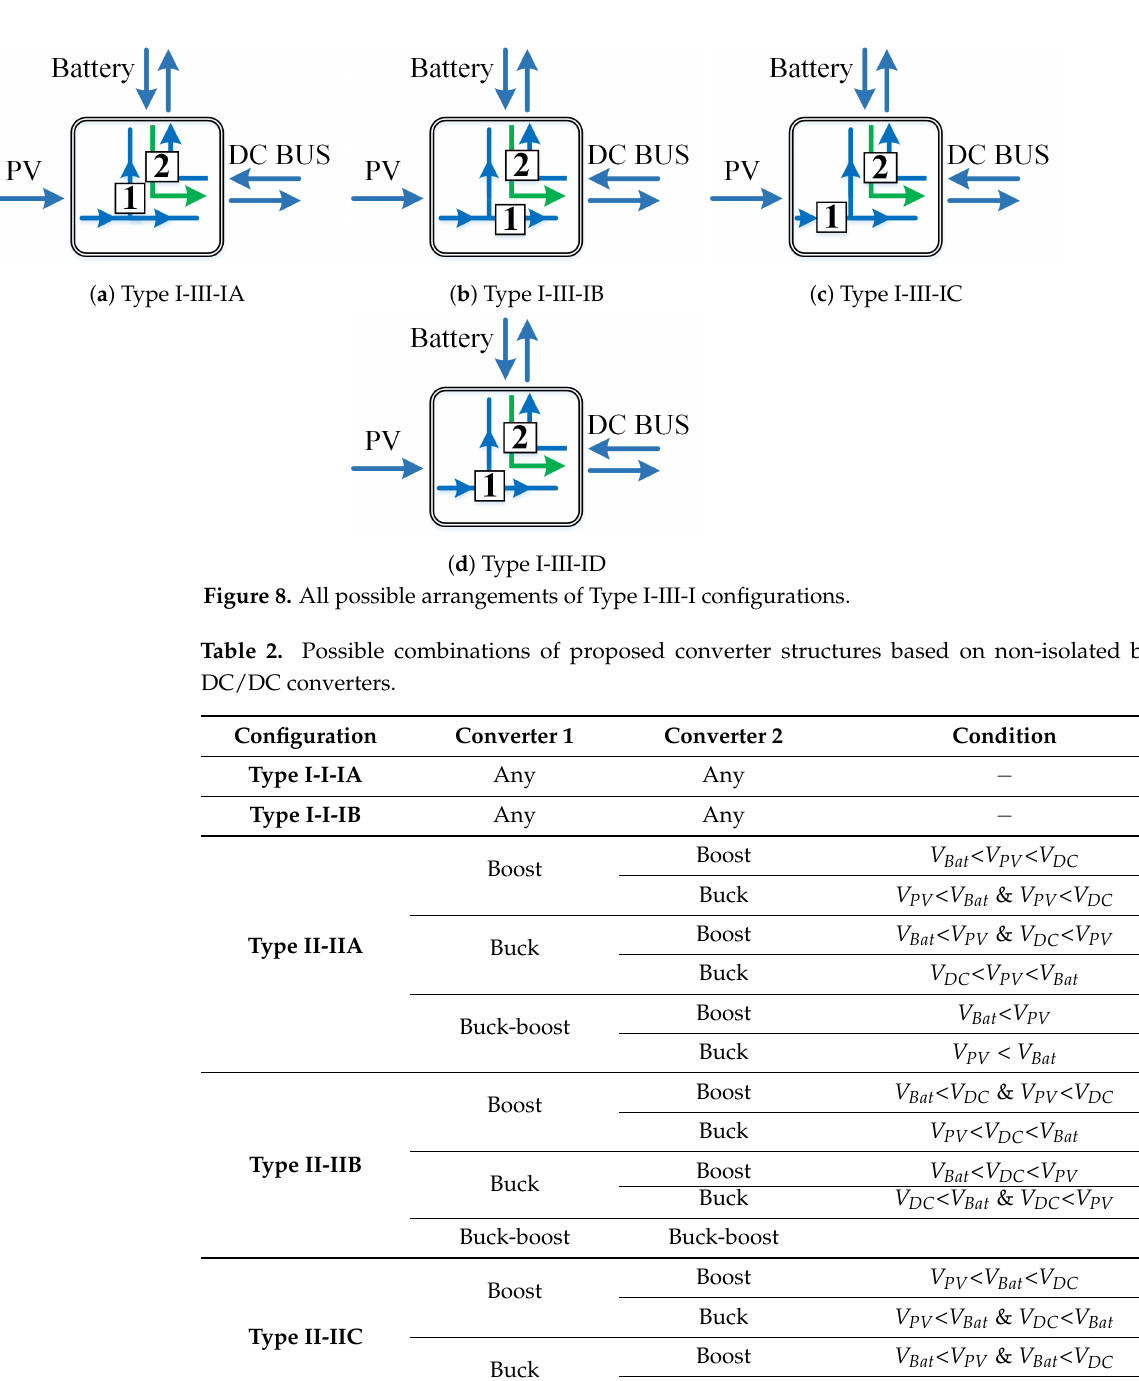
Figure 7. Modified configurations of Type II-II [23].